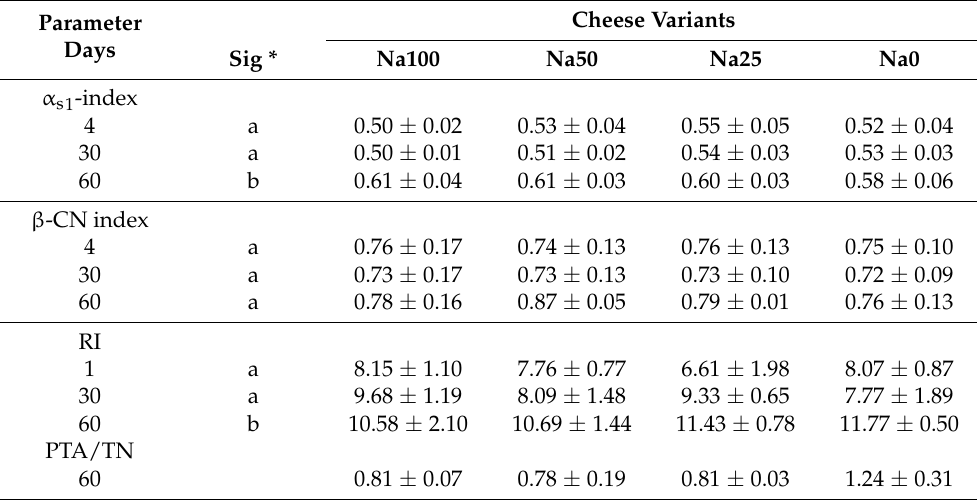
Table 3. Proteolysis parameters of white brined cheese manufactured with different ratios of NaCl and KCl after 1, 30 and 60 days of